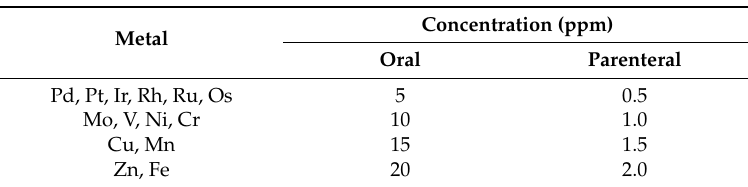
Table 1. Maximum acceptable concentration limits for the residues of metal catalysts that can be present in pharmaceutical products